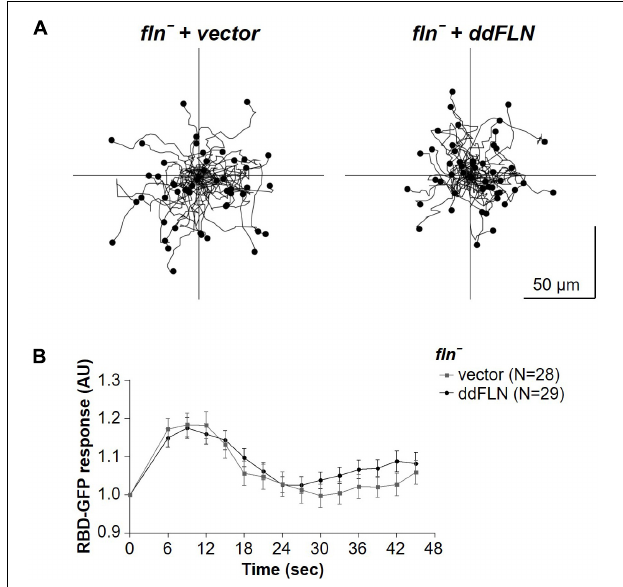
FIGURE 3 | Response to chemical stimulation and random motility is not affected by lack of filamin. (A) fln - cells expressing RBD-GFP and either mCherry-tagged ddFLN or empty vector were imaged using brightfield illumination under 200X magnification every 10 s as they were migrating without any stimulation. Tracks of 50 individual cells for each condition from one representative experiment are shown. Average data from four separate experiments is shown in Table 1 . (B) The same cells as in panel (A) were stimulated with 100 µ M folic acid at time 0. Response was measured as an inverse of drop in cytosolic intensity of RBD-GFP. Data is shown as mean ± SE. Number of cells analyzed is provided in the key and was pooled from four (ddFLN) or three (vector) separate stimulations.